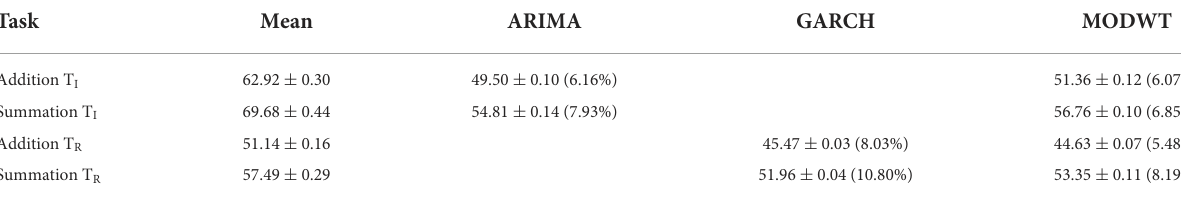
TABLE 6 Mean mental arithmetic response times (s) forecasted for 100 trials using time (ARIMA, GARCH) and time/frequency (MODWT) domain model fits.